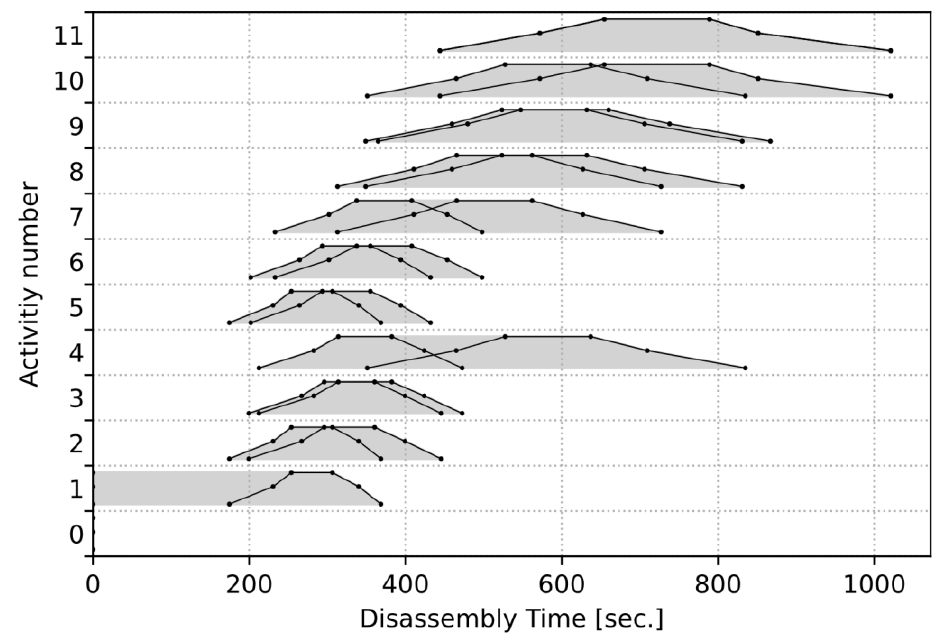
Figure A3. “ ” fuzzy Gantt chart for each disassembling step.